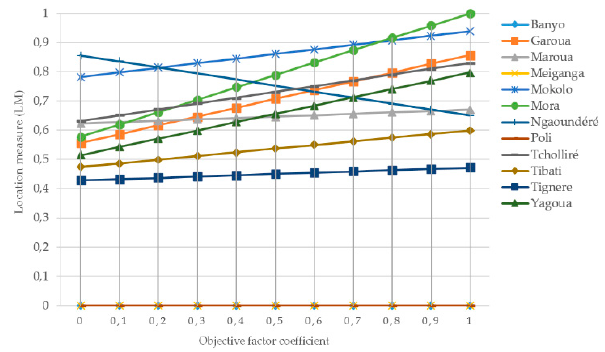
Figure 9. Sensitivity analysis of location measure for each site with respect to objective factor coefficient.